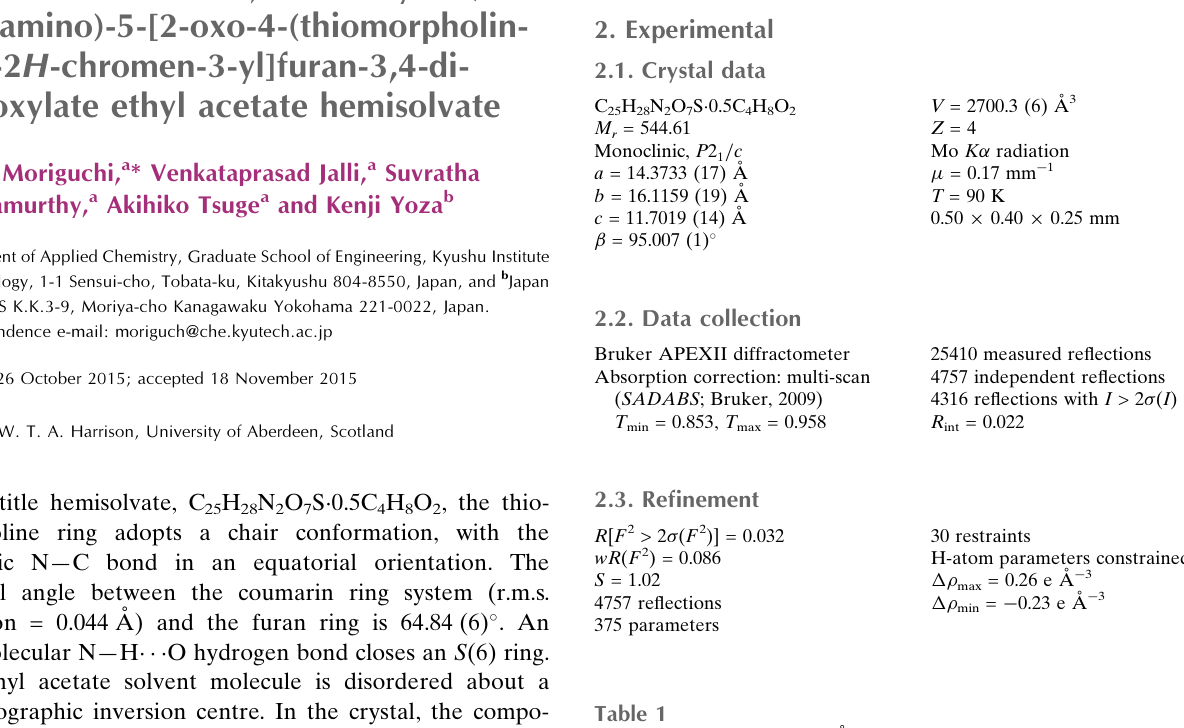
Hydrogen-bond geometry (A˚ , (cid:3)